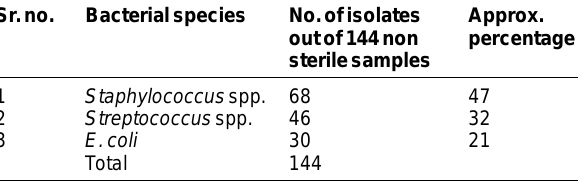
Table-1. Frequency of isolation of Staphylococcus , Streptococcus and E.coli from clinical samples of